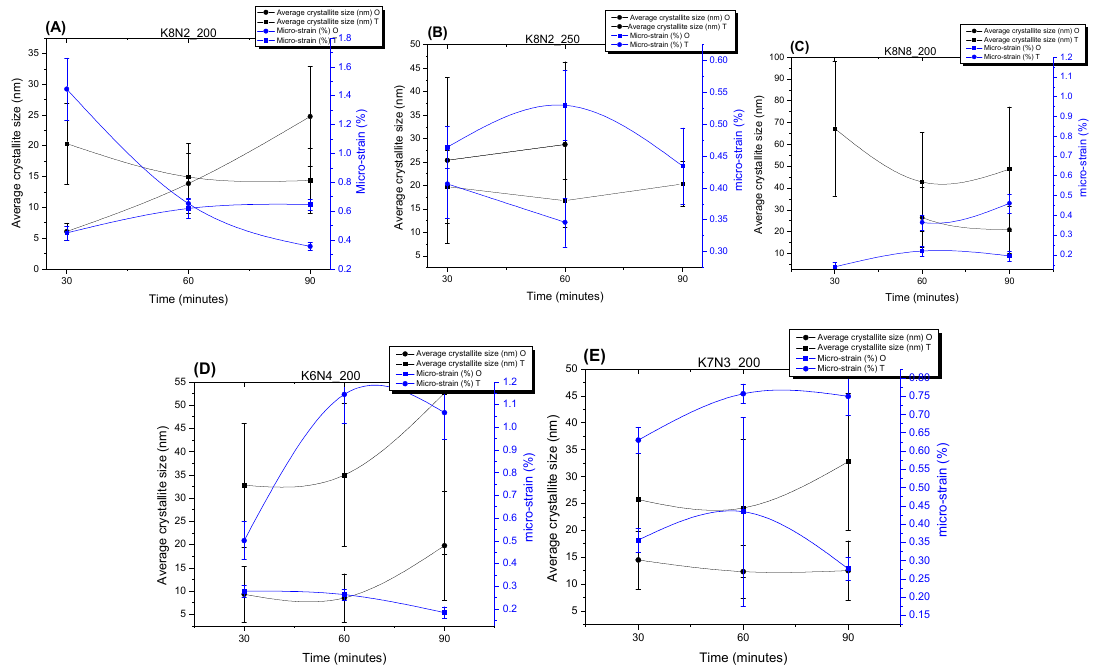
Figure 7. Average crystallite sizes and micro ‐ strain variation in KNN particles’ orthorhombic and tetragonal symmetry, crystallized depending on the HTMW dwelling time at 200 °C and 250 °C, for the series of samples K8N2_200 ( A ), K8N2_250 ( B ), K8N8_200 ( C ), K6N4_200 ( D ) and K7N3_200 ( E ).